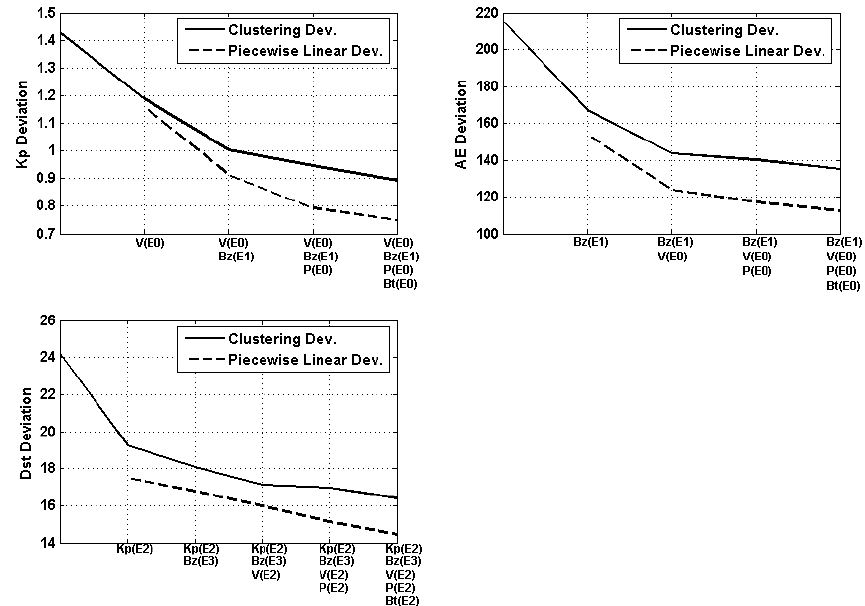
Fig. 6. (a) to (c) show the resultant decreases in <σ> p and <σ> c of K p , AE , and D st , respectively, when the delays of K p , AE , and D st responses are incorporated in the successive localization process: (a) deviation of K p distribution when V sw (E0), IMF B z (E1), P sw (E0), and IMF B tot (E0) are successively localized; (b) deviation of AE distribution when IMF B z (E1), V sw (E0), P sw (E0), and IMF B tot (E0) are successively localized; (c) deviation of D st distribution when K p (E2), V sw (E2), IMF B z (E3), P sw (E2), and IMF B tot (E2) are successively localized. Here E0 and E1 indicate 0 and 1h, respectively, earlier than the geomagnetic index observations. The localization processes clearly reduce the deviations